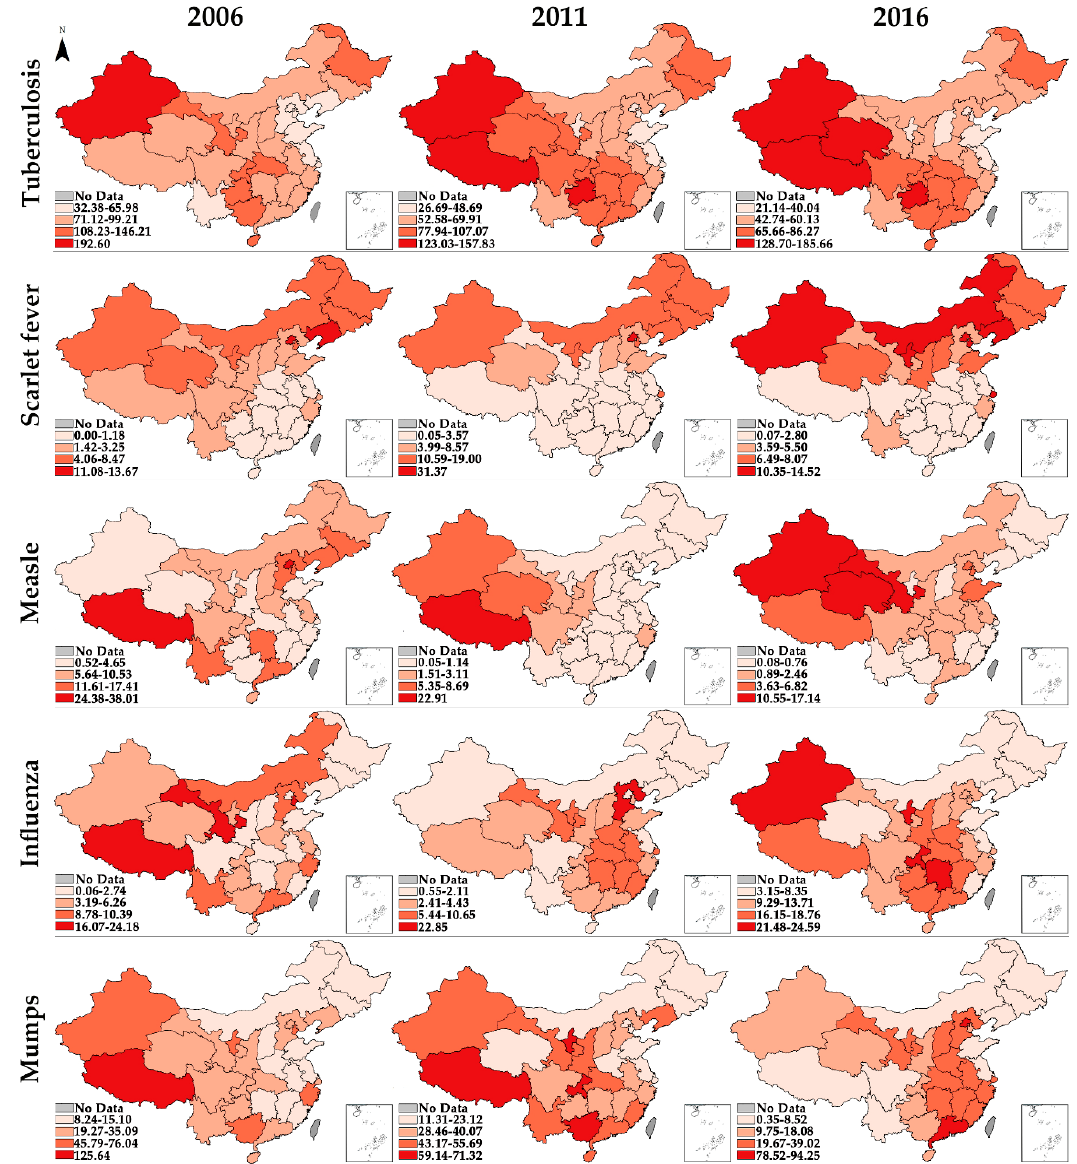
Figure 3. Hierarchy maps of the incidence of RIDs in 2006, 2011, and 2016.